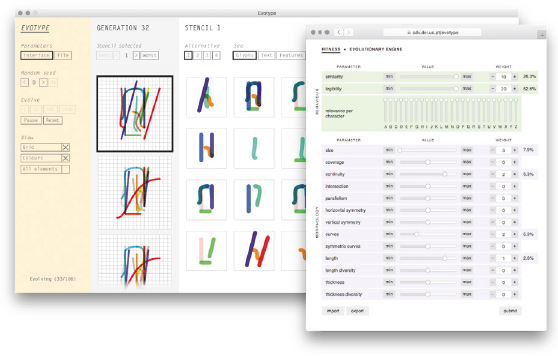
Figure 7: Screenshot of the framework, consisting of the evolution- ary system (back) and the fitness function design interface (front). A demo video can be seen at http://cdv.dei.uc.pt/2018/complexity/